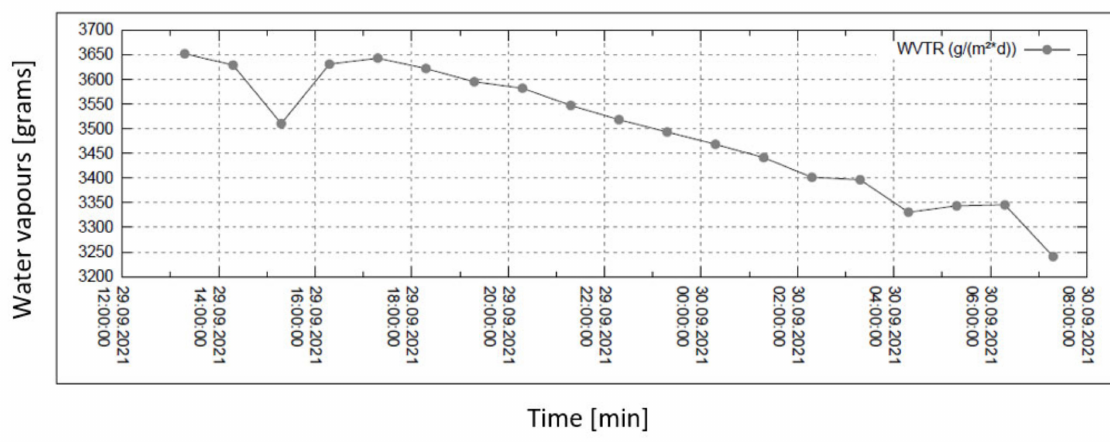
Figure 8. Permeability of water vapour over 24 h with 60% external